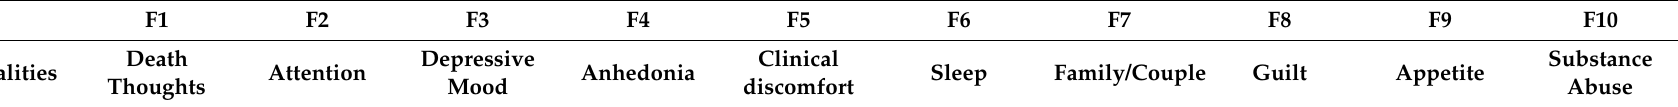
Table A3. Saturations and factorial structure of the DCET items at the moment “always” (N =